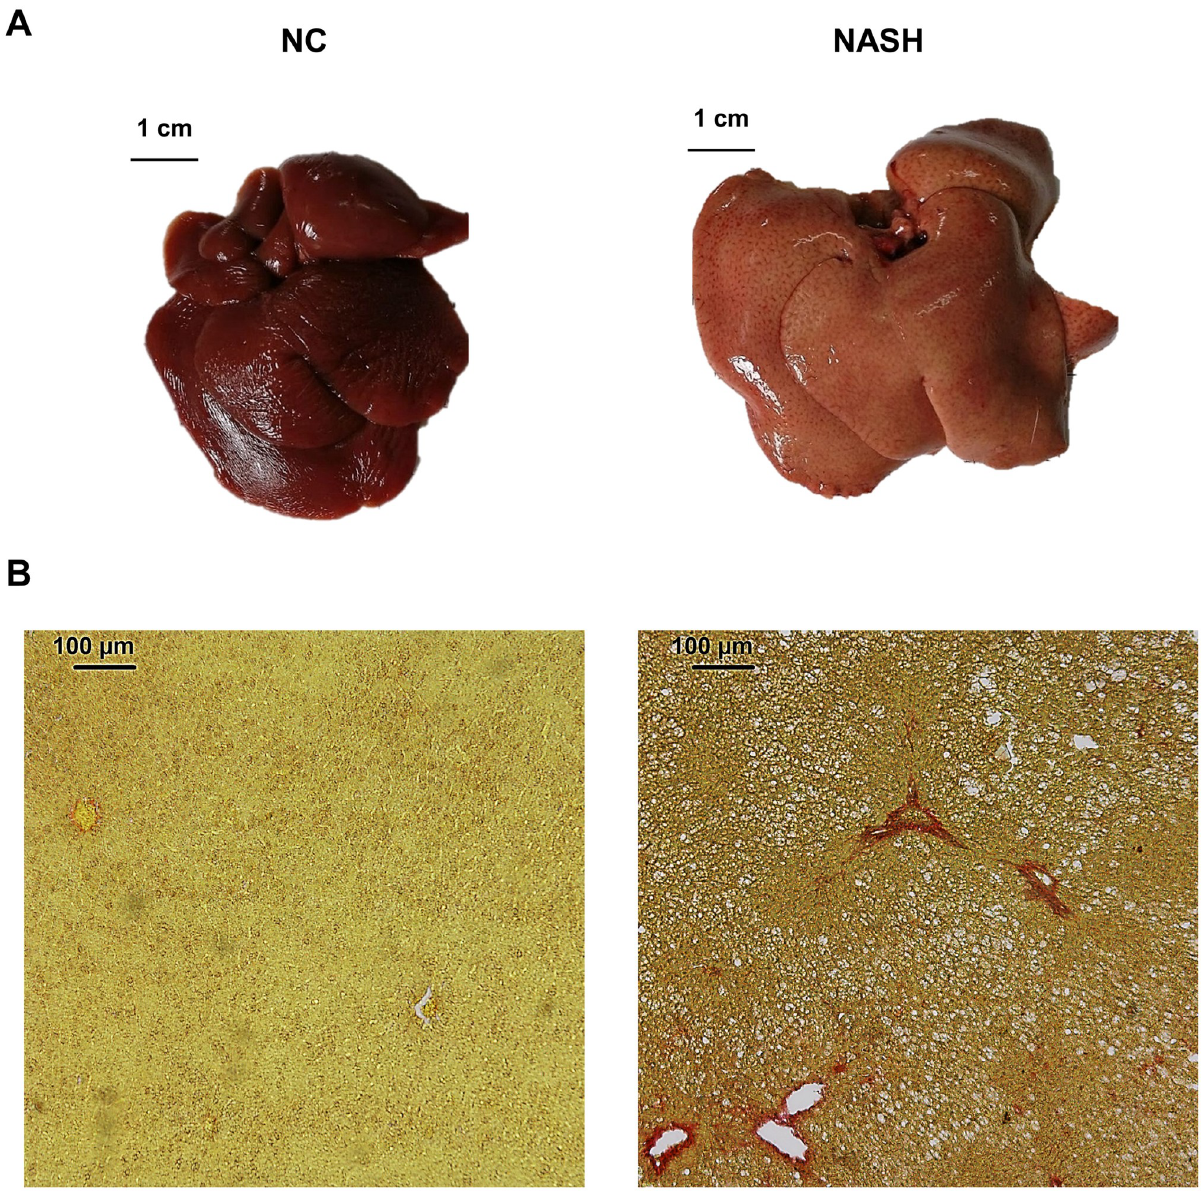
Fig 2. Liver examination. ( A ) Macroscopic view of NC and NASH livers. ( B ) Microscopic (10x) view of NC and NASH livers after being stained with picrosirius red. The NASH group presented with